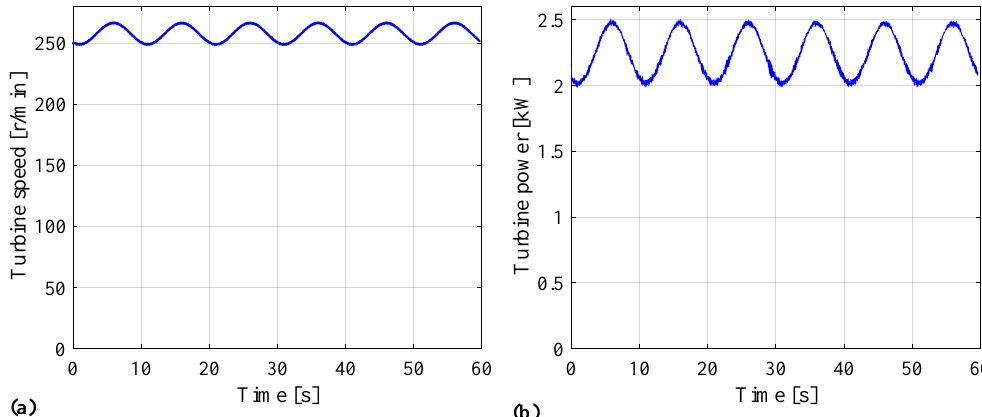
Figure 26. Measured ( a ) turbine speed with a frequency of 0.1 Hz and ( b ) the turbine power response.